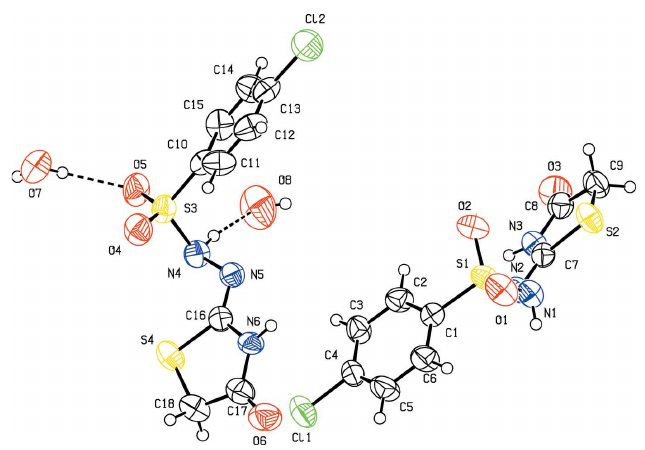
Figure 1 The molecular structure of the title compound showing displacement ellipsoids at the 50% probability